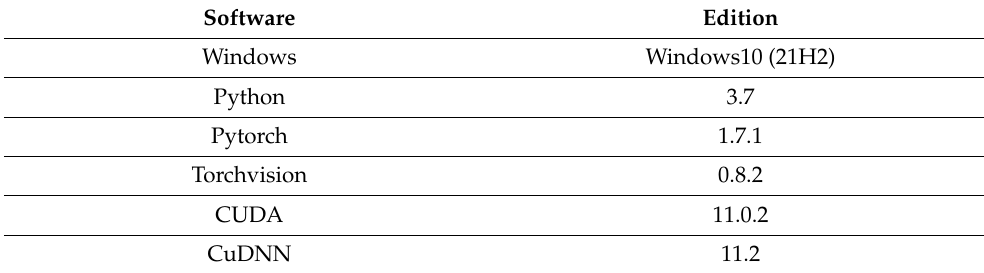
Table 2. Software used in experiments.